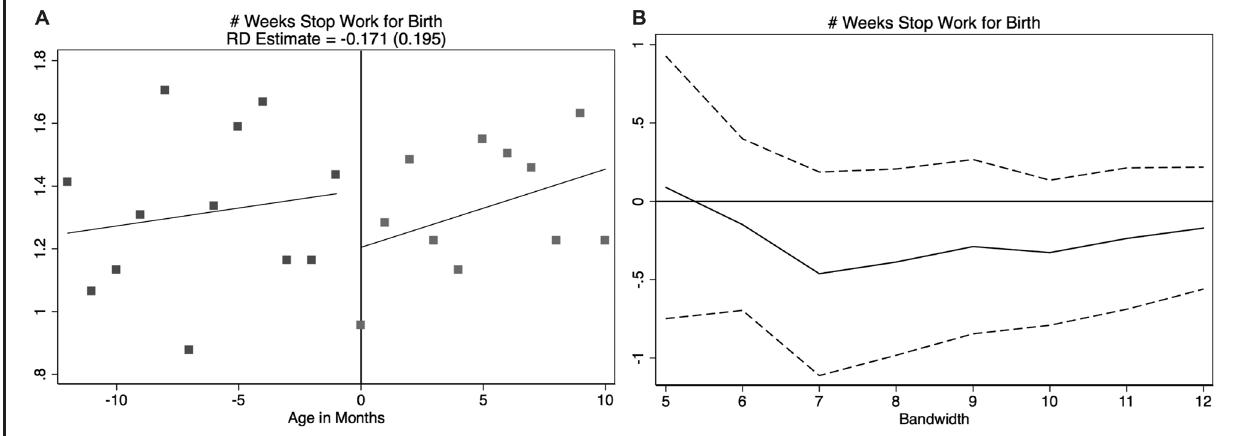
mothers who gave birth on or after January 1 2011, were able to receive either the PPL or the Baby Bonus, dependent upon eligibility for both. Thus, only mothers who had family income below $75,000 after 6 months of childbirth and who had taxable income of $150,000 or less in the year before birth were eligible for both the Baby Bonus and PPL (but still only able to receive one or the other). Due to data limitations, I am unable to limit the Baby Bonus analysis to those who were eligible for both the Baby Bonus and PPL. Therefore, I estimate the effect of PPL on the average Baby Bonus receipt among the restricted sample (i.e., those women who reported being employed while pregnant) in the PETS.